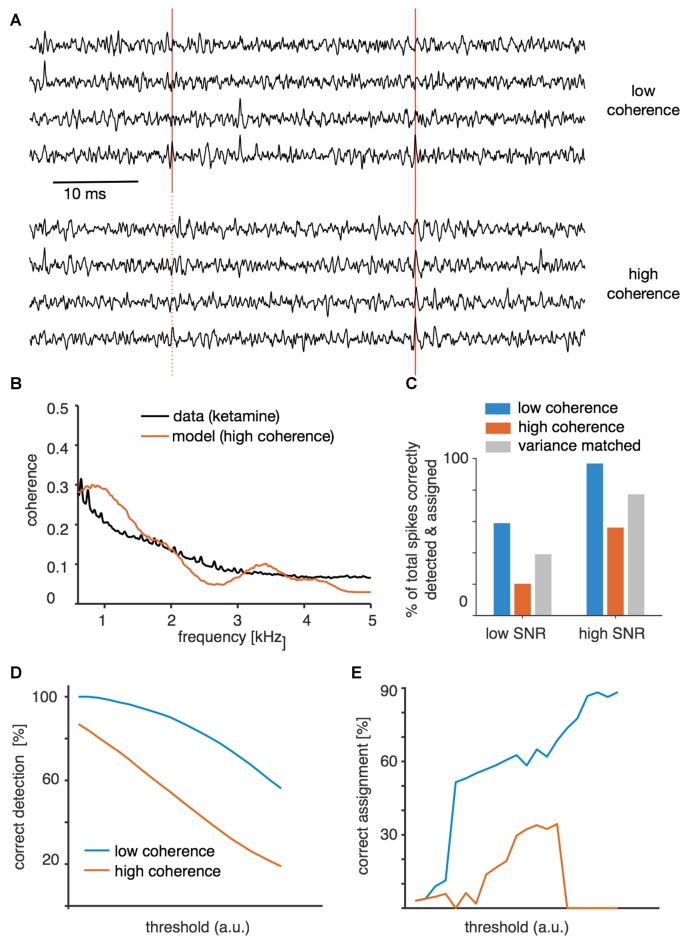
Spike sorting of synthetic data. (A) Example traces from the low signal-to-noise ratio (SNR) condition for high and low global coherence backgrounds, including one foreground spike correctly identified in both backgrounds (solid red lines) and one spike that was detected in the control, low-coherence background but missed in the high-coherence background (dotted red line). (B) Modulation of background activity was adjusted to match local coherence observed in the real data obtained under ketamine anesthesia. (C) Spike-sorting success at low and high SNR (mean spike amplitude relative to background variance). The proportion indicated is the overall success rate for correctly assigning the originally entered foreground spikes, and is thus a result of both detection and correct clustering. For each spike-to-background SNR level, synthetic data were generated with either low coherence, high coherence, or high coherence but with variance matched to the low-coherence case. (D) Success of event detection for different threshold values for the low SNR case for both high- and low-coherence backgrounds. (E) Success of correctly assigning successfully detected events.